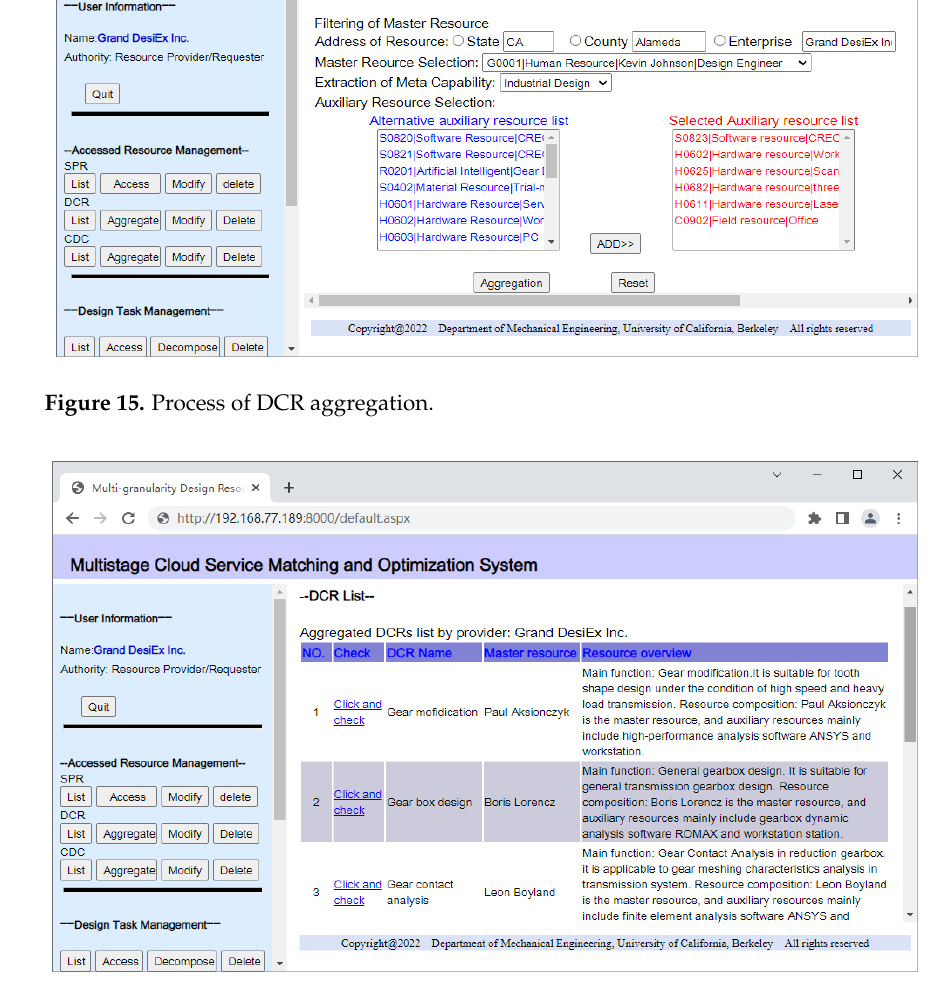
Figure 16. DCR list.